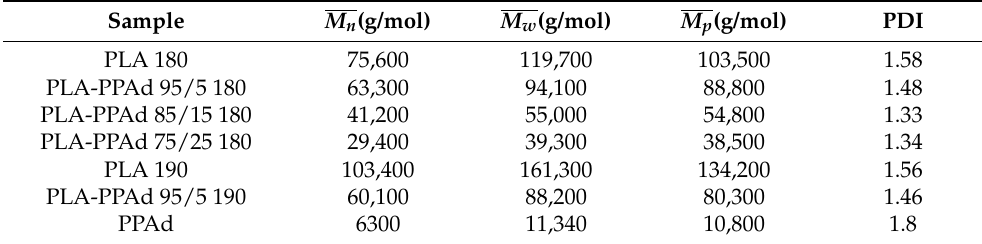
Table 3. Molecular weight and PDI (GPC) of PLA and the copolymers with PPAd.